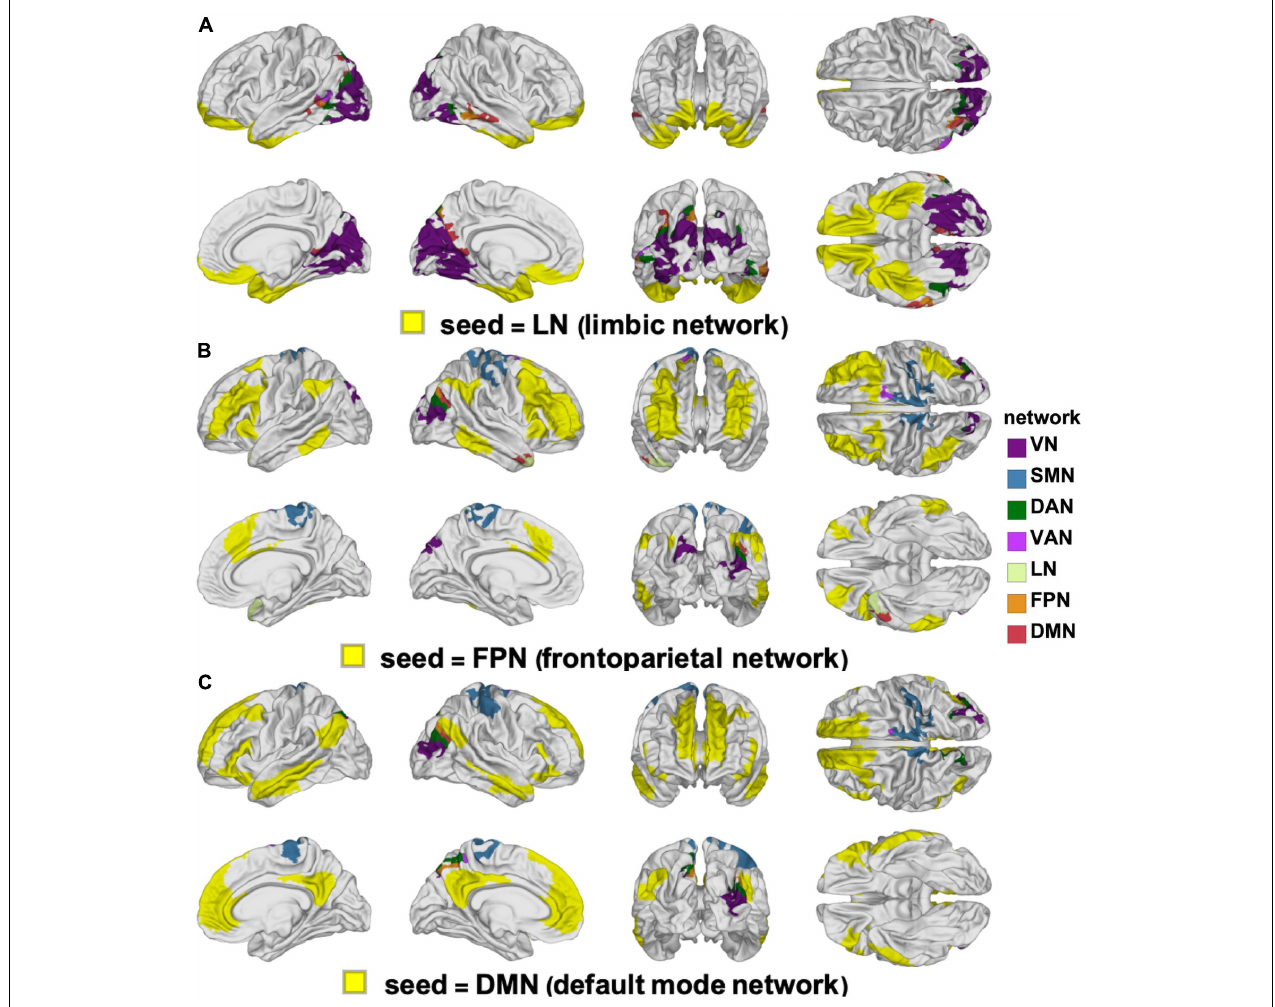
FIGURE 7 | Like Figure 6 , for the LN (A) , FPN (B) , and DMN (C) . DMN, default mode network; FPN, frontoparietal network; LN, limbic